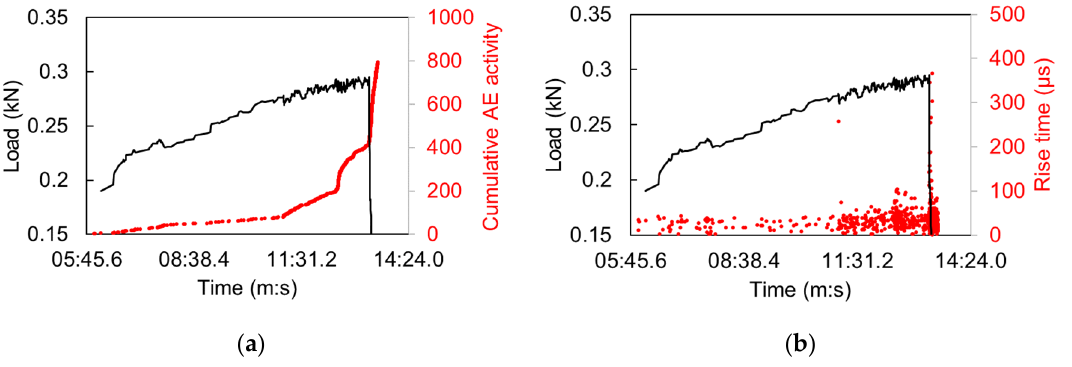
Figure 6. Load history with ( a ) cumulative hits and ( b ) rise times from a curved TRC beam 25 mm wide.